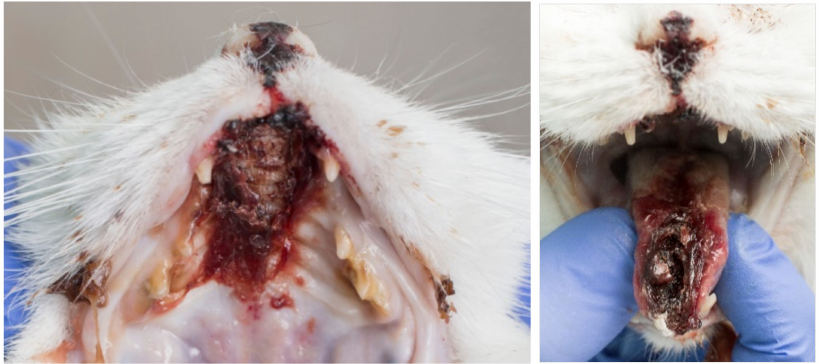
Figure 9. Severe necrosis (philtrum, palate, tongue, lip commissure) in a cat with VS-FCV infection. ©University Animal Hospital Zurich, Regina